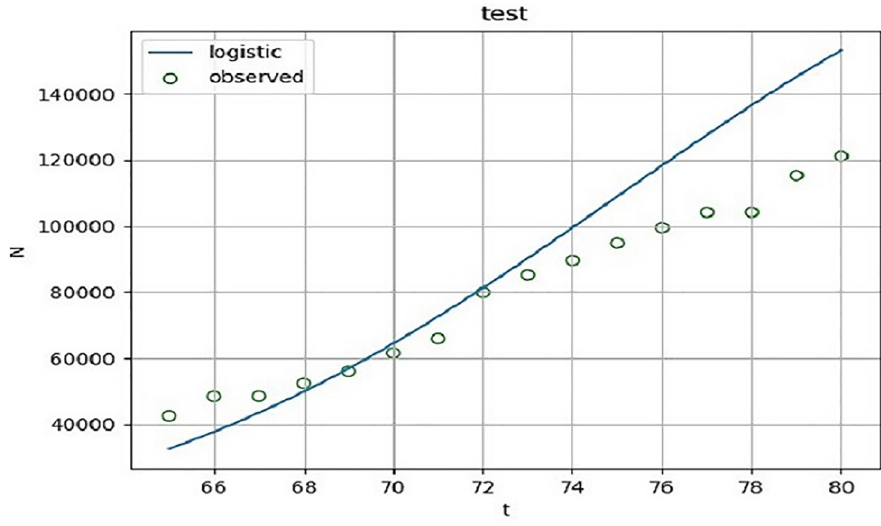
Fig 2. Logistic curve fitting diagram of cumulative confirmed cases of COVID-19. The cumulative confirmed cases of COVID-19 in the UK from April 4 to April 19, 2020 are used as a test set. SPSS is used to conduct Logistic curve fitting for the daily accumulative confirmed number in this period to evaluate the effectiveness of the model.